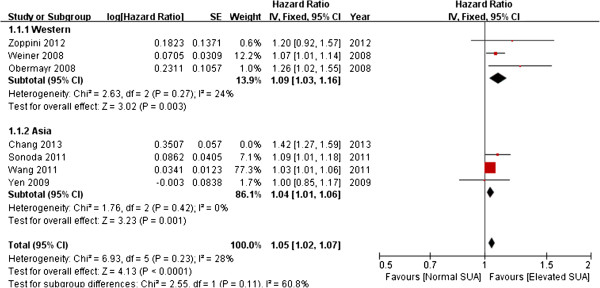
Forest plot of association between SUA and new-onset CKD (excluding the study by Chang et al. [[17]]).